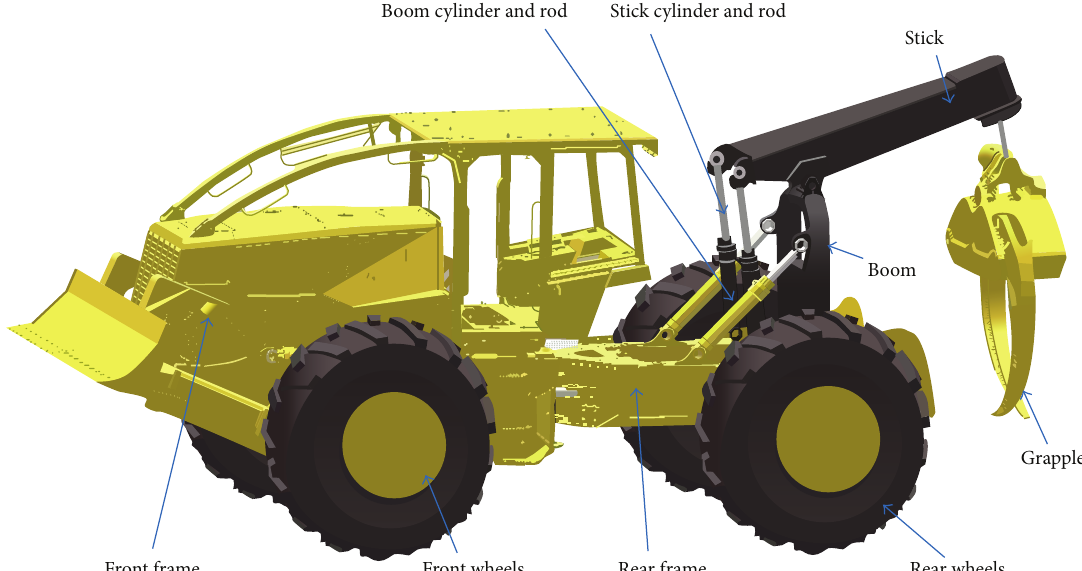
Figure 11: Grapple skidder forestry machine.